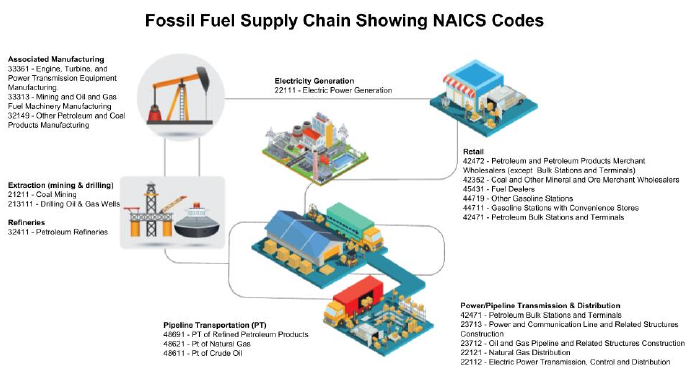
Figure 1. Supply chain of the energy sector (fossil fuel) shows the North American Industry Classification System (NAICS) codes along the various segments of the energy supply chain in upstream, midstream, and downstream industries. The upstream oil and gas industries include exploration, extraction, and production. The midstream industries involve the transportation and storage. The downstream industries incorporate petroleum crude oil refining as well as the